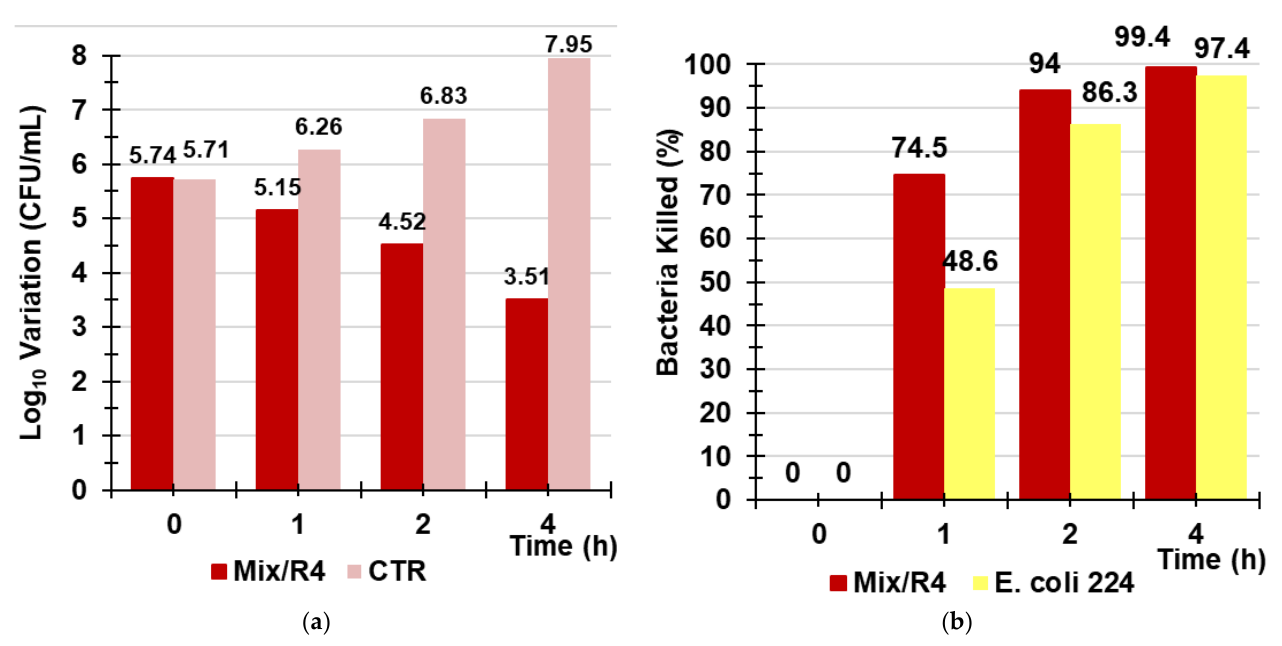
Figure 12. Variation of Log 10 (CFU/mL) observed when a mixture of Group B Salmonella species 505, E. coli 462 (New Delhi metallo- β -lactamase producer), E. faecium 503, and E. faecalis 365 strains was exposed for 1, 2, and 4 h to R4 (red bars) vs. that of CTR (pink bars) ( a ); percentage of the bacterial cells killed by R4 after 1, 2, and 4 h of exposure when tested against the mixture (red bars) and against E. coli 224 (yellow bars) ( b ).